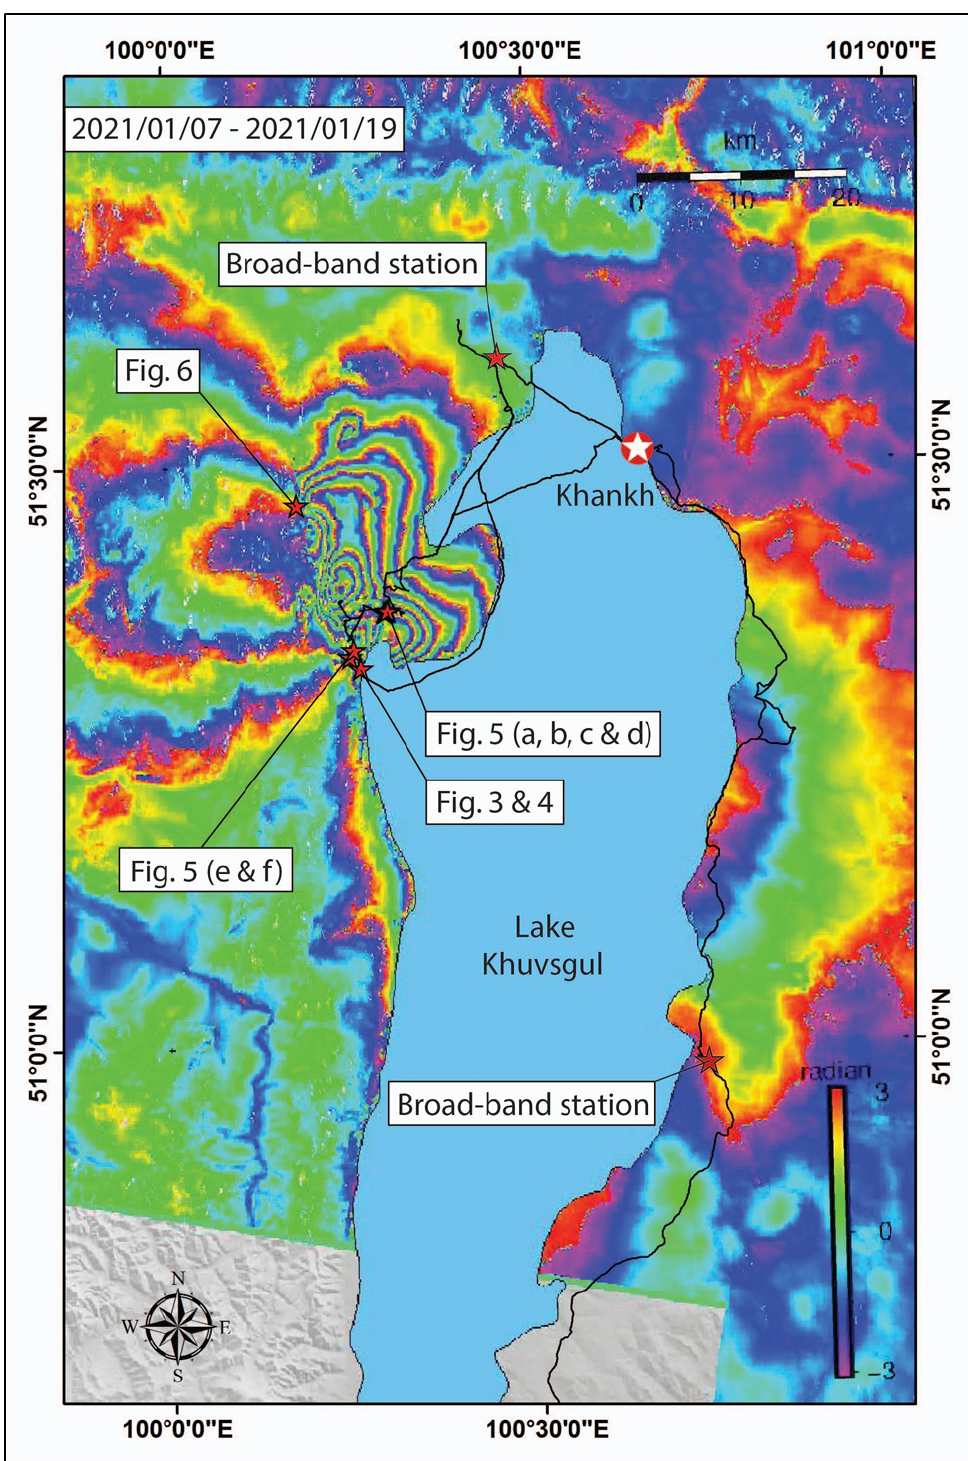
Fig. 8. A Sentinel-1 InSAR interferogram from data of a descending track covering the Khankh earthquake M 6.7. The red stars represent the locations of Figs. 3, 4, 5 and 6 and also show the w locations of the broad-band seismic stations those were installed by us in order to record aftershocks. The black curved traverses express our track during the field work. The white star marks the Khankh